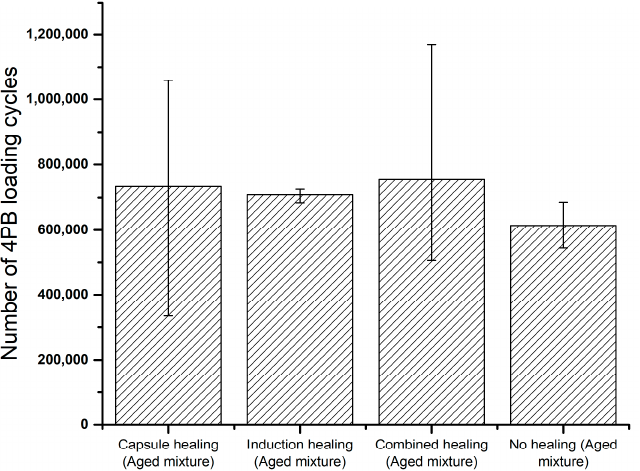
Figure 16. Number of 4PB fatigue loadings leading to failure of all beam specimens.